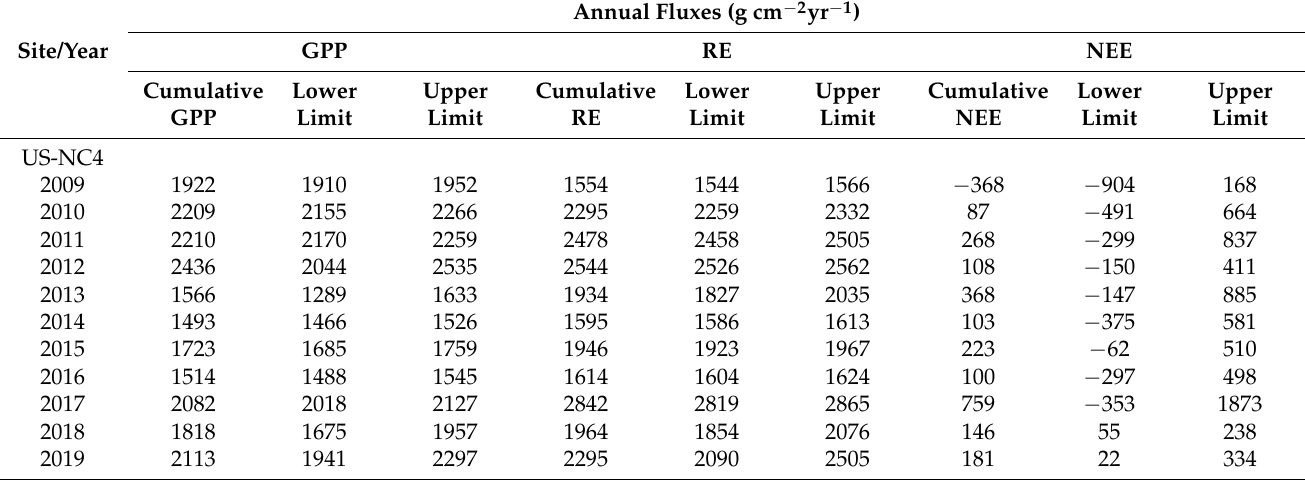
GPP NEE Table 1. Annual gross primary production (GPP), ecosystem respiration (RE), and net ecosystem Cumulative Lower Upper Cumulative Lower Upper Cumulative Lower Upper exchange (NEE) from 2009 to 2019. The upper and lower limits were determined using the uncer- GPP Limit Limit RE Limit Limit NEE Limit tainty analysis of [57] for NEE, while Monte Carlo (bootstrap) simulation was used for GPP and RE.